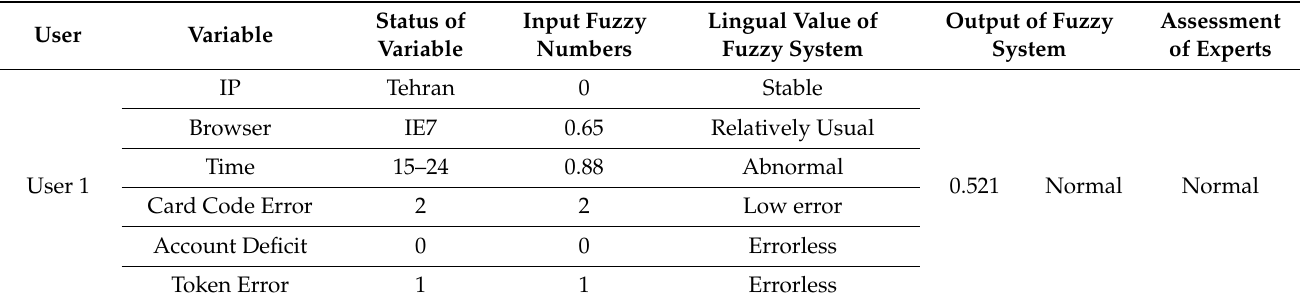
Table 12. Status of variables in user-1 (source: research